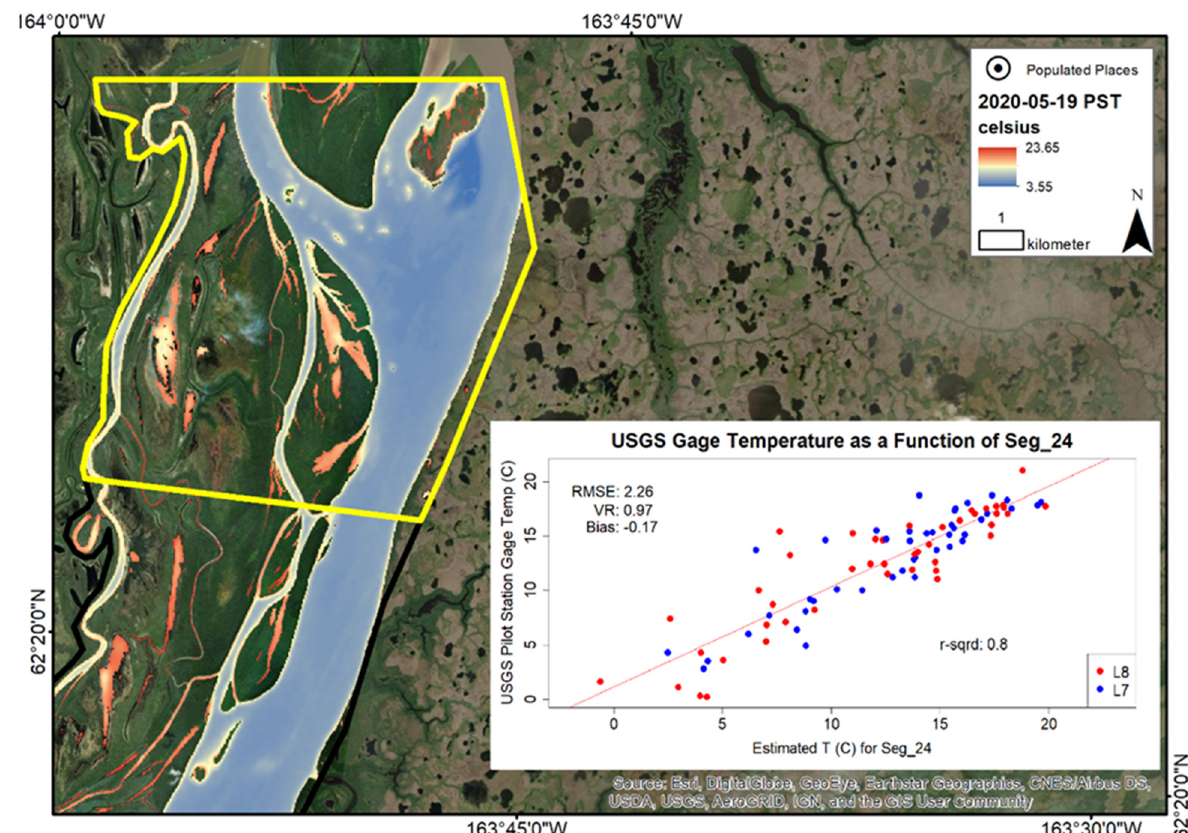
Figure A22. Segment 24 captures the Yukon River dividing into two large channels in addition to a portion of river continuing to flow within the Tunurokpak Channel. The east bank of the river abuts low hills and slight uplands while the west shore is broken by islands, small sloughs, and channels. The western extreme of the Yukon lies in the Tunurokpak Channel. Water temperatures are estimated to have cool water temperatures similar to those of the main stem. A large channel isolates a large unnamed island that, at high river stage, hosts a number of backwater features. At high stage flow, the Yukon is inundated bank to bank aside from large forested islands. At lower stages, numerous sand and gravel bars emerge upstream of these islands. Several small warm water features reveal these submerged islands in the scene above. This is the final 10 km stretch of river captured in our analysis. Similar to the preceding segment, pST is 100% with no NoData gaps. Despite this part being the river segment furthest downstream of the Pilot Station gage, correlation between pST estimates and the Pilot Station recordings is consistent with the majority of other river segments (RMSE = 2.26 °C, r 2 = 0.797).